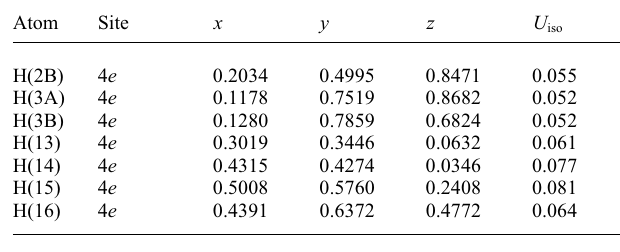
Table 3. Atomic coordinates and displacement parameters (in Å 2 ) .